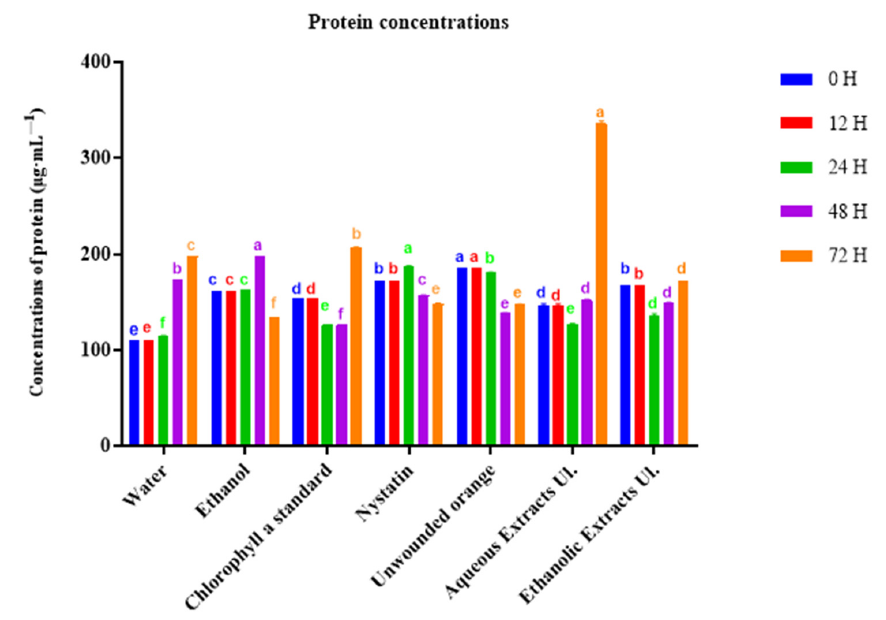
Figure 2. Protein concentration ( µ g · mL − 1 ) of “Valencia late” oranges treated with the aqueous or ethanolic extract of Ulva lactuca (Ul.) measured during incubation. For each time point, columns (treatments) with different letters are significantly different: p < 0.05 (Duncan’s test).